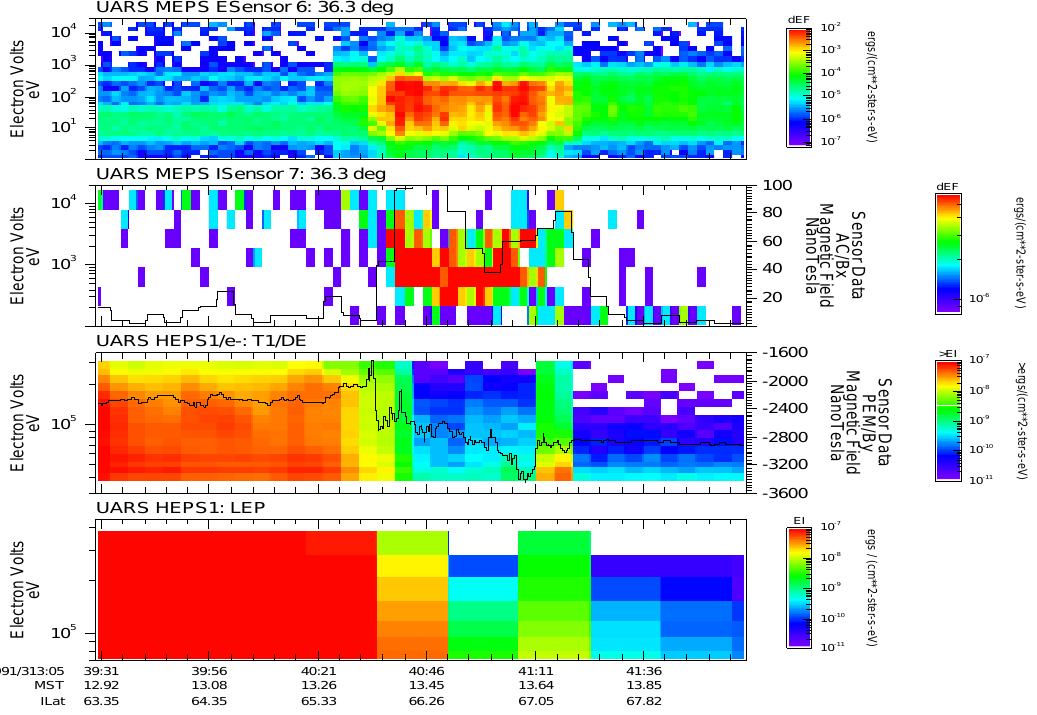
Fig. 3. UARS data from 9 November 1991, showing a V signature without the dispersion tail. Top panel is electrons 36 ◦ from zenith and the second panel is ions from the same direction. The third spectrogram is electrons from 35 keV up to 300 keV. The bottom panel contains ions from 70 keV to 400 keV. The line plot in the second panel is integrated magnetic field wave power from 0 to 100 Hz and the third panel has a line plot of the B y magnetic